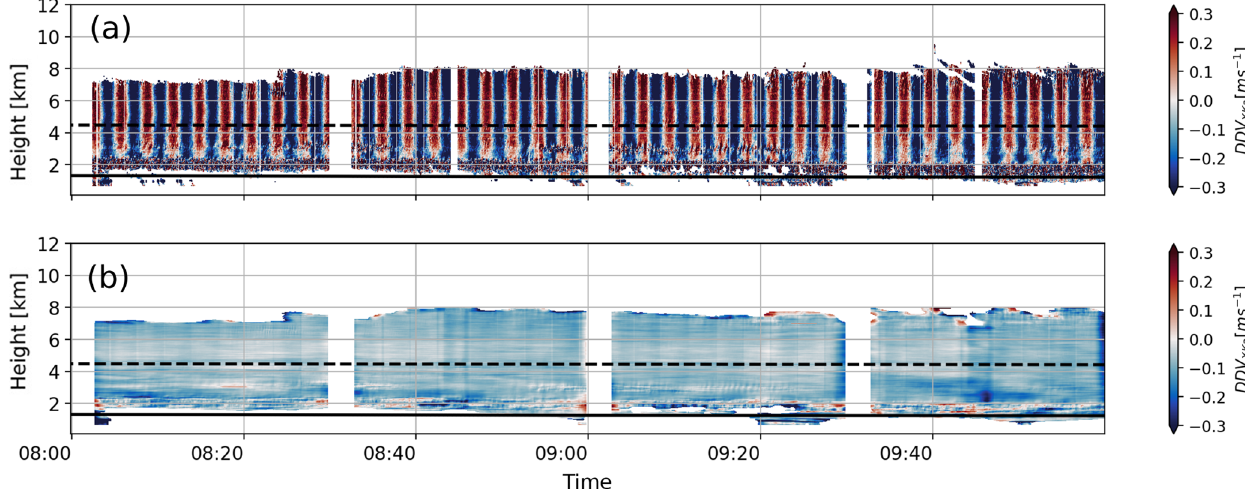
Figure 7. Time–height plots of the dual mean Doppler velocity using the Level 2 data of 20 November 2015. The dashed line and the contin- uous line are the − 15 and 0 ◦ C isotherms, respectively. Panel (a) shows the DDV XKa using the original data from Level 2. Panel (b) shows the DDV XKa after applying a 3min moving